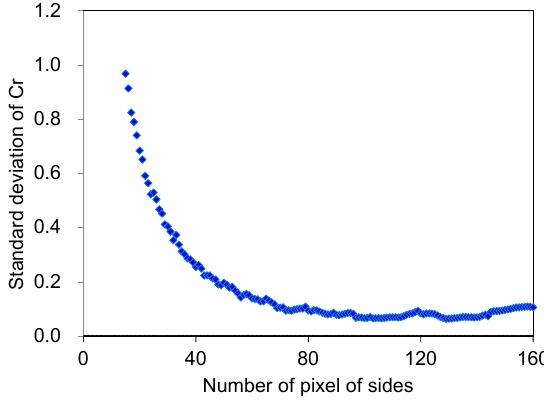
Figure 6. Standard deviation of Cr values with various averaged areas.